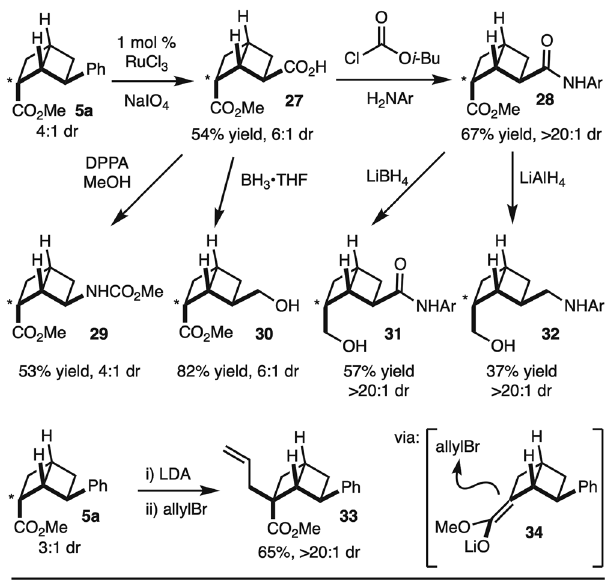
Fig. 4 | [2]-Ladderane as rigidi fi ed 1,3-cyclohexane. The ladderane compounds canbeconvertedviastandardchemicalreactionstofunctionalgroupscommonto druglikemolecules.DPPAdipenylphosphorylazide,LDAlithiumdiisopropylamide.